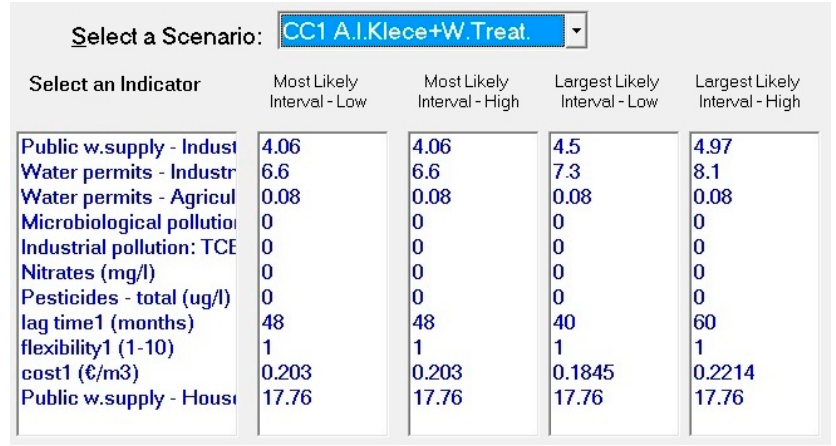
Figure 3. Ranking criteria for the management option “artificial infiltration Kle č e-Roje with water treatment.”